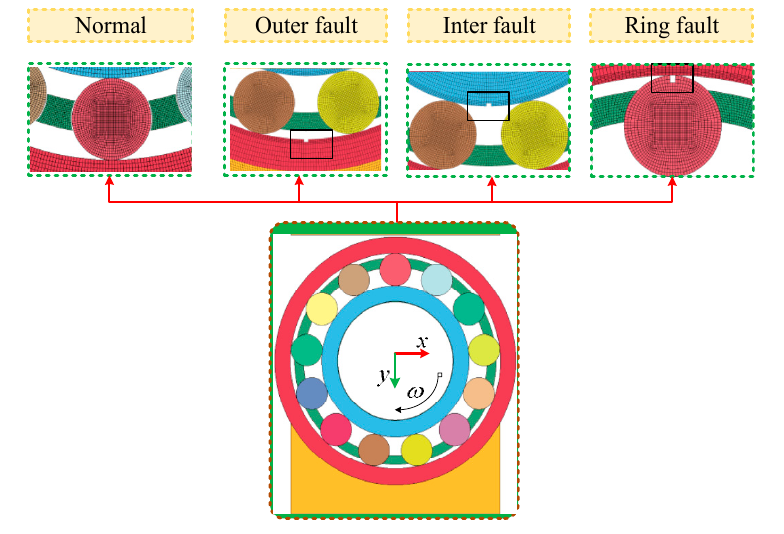
Figure 3. Bearing dynamic model.